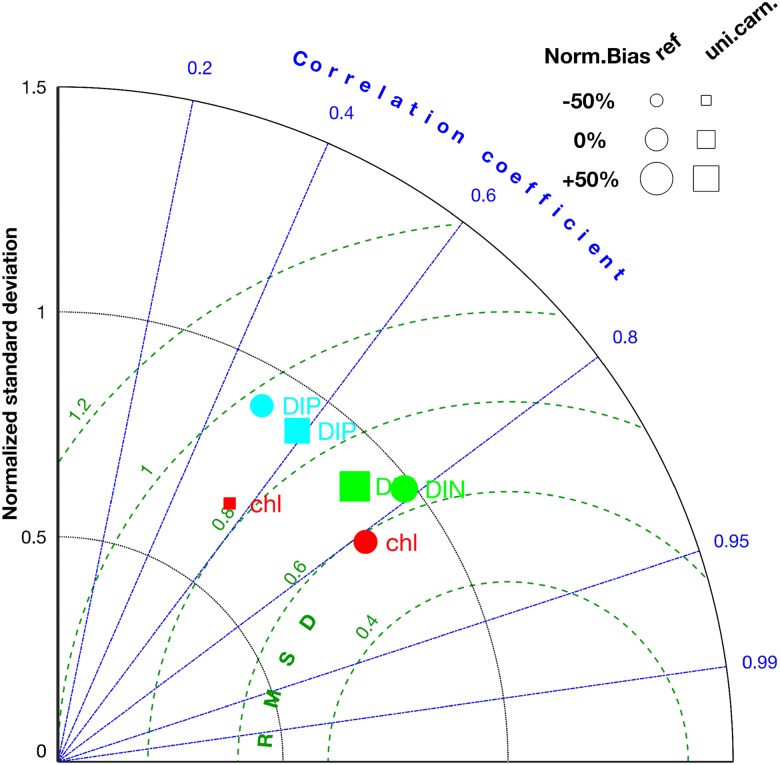
Taylor diagram displaying four statistical measures of the comparison of model results with station time-series data.(1) The mean-normalized bias determines the size of the plot symbols, (2) the root-mean-squared deviation (RMSD) normalized by the standard deviation in the data, STD, the distance from the reference point at the right bottom, (3) the STD-normalized standard deviation in the simulated time-series the radius position in the non-linear polar grid (black curves), and (4) the correlation between model and data the angle (blue lines). The measures of the reference run (circles) and the scenario of “uniform carnivory” (squares) are compared for the three observables DIN (green), DIP (cyan), and CHL (red).